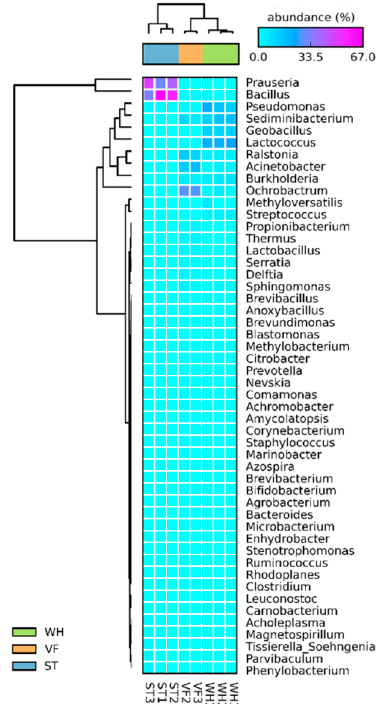
Figure 6. Heat map of the 50 most abundant genera in VF, WH, and ST. For each sample, the number of reads per OTU was normalized by total number of reads from the sample.